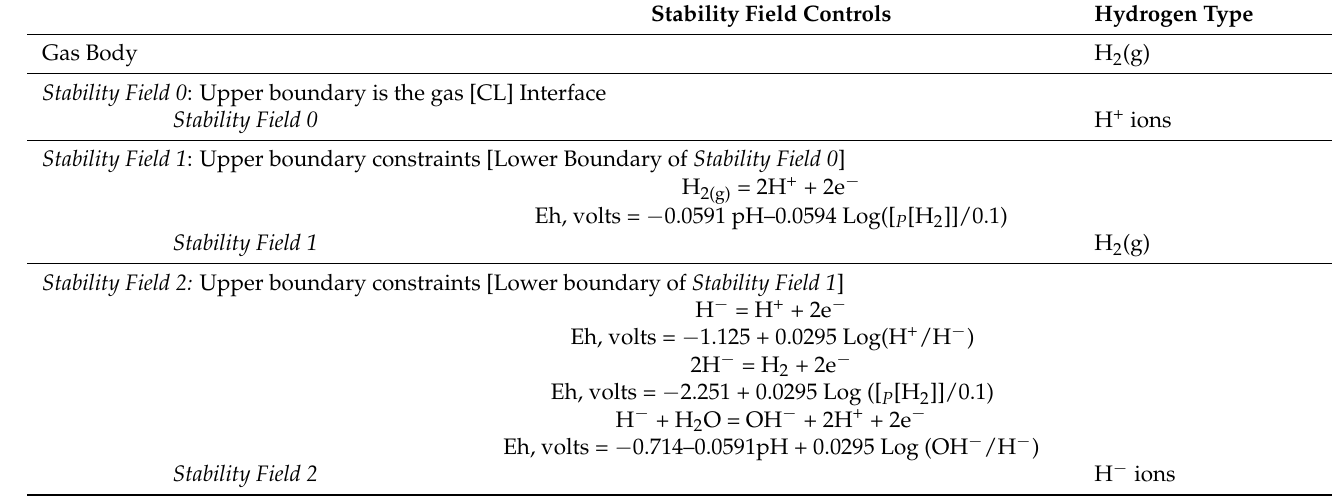
Table 11. Redox (Eh:pH) stability field regimes in the [CL]. The Eh of the upper boundary of Stability Field 2 , decreases with increasing pressure, and decreases with the increasing availability of H + and OH − . In a Nernstian, or Faradaic reaction, basic chemistry [14,31] defines: Eh, volts